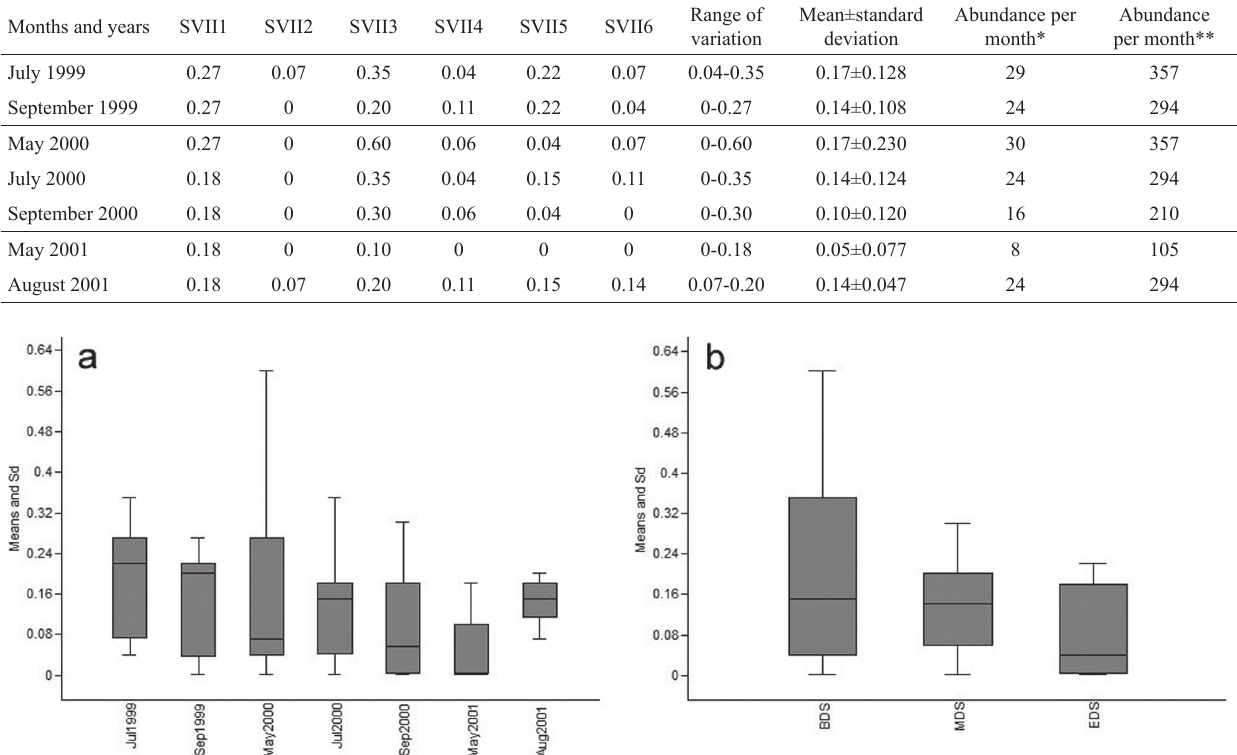
Table 2 . Density data (ind.m -2 ) for Eigenmannia vicentespelaea in six reaches from São Vicente II cave (SVII). Abundance